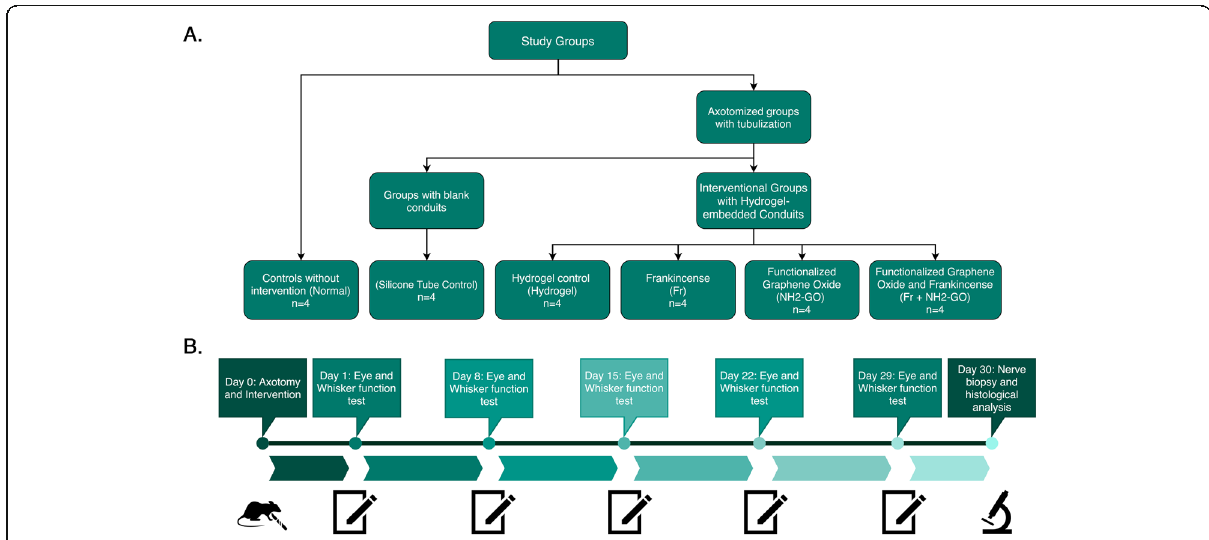
Fig. 1 Study groups ( a ) and timeline ( b ). Nerve biopsies were obtained and fixed with paraformaldehyde 30 days following axotomy and